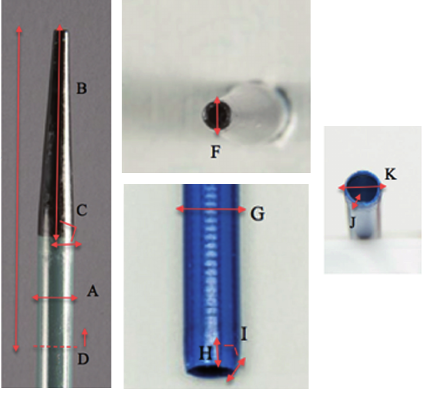
figure 2 - Tip contour and sheath characteristics.